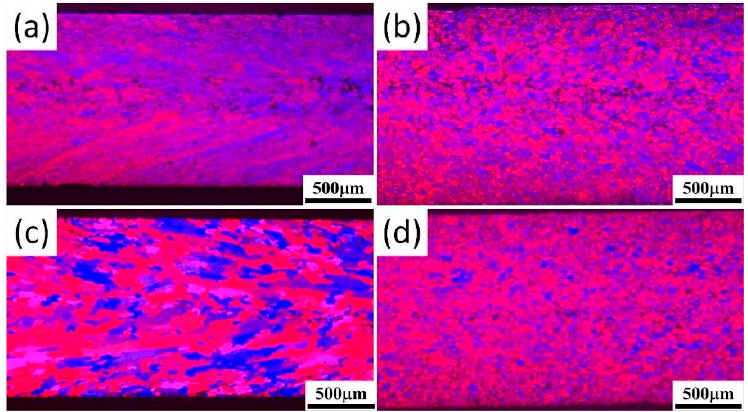
Figure 7. OM test results: ( a ) ACMZ, as cast; ( b ) ACMZ + 0.3TiC-TiB 2 , as cas; ( c ) ACMZ, isothermal holding ; ( d ) ACMZ + 0.3TiC-TiB 2 , isothermal holding.